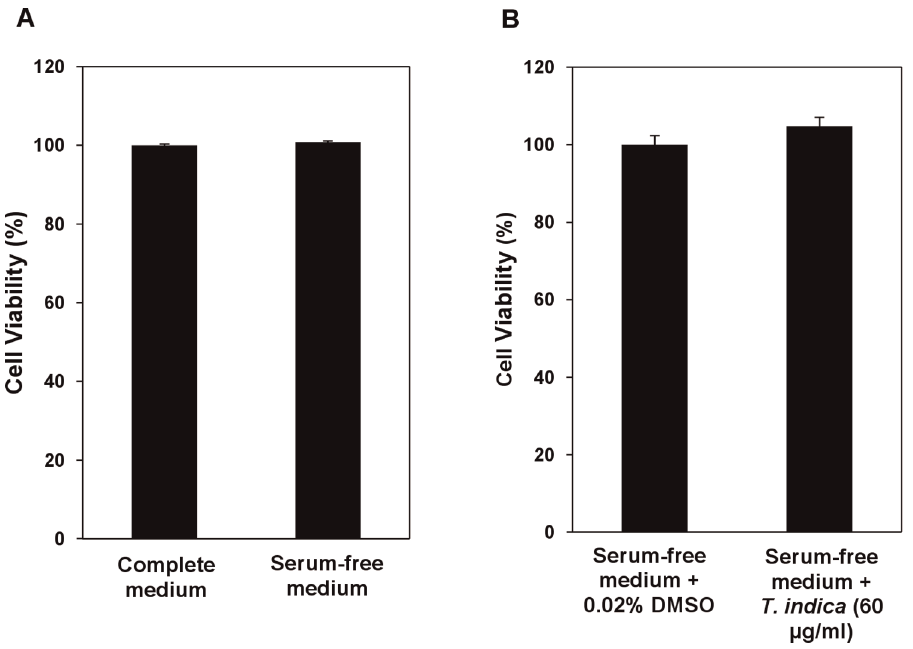
Figure 1. MTT analysis to assess cell viability. HepG2 cells were grown in complete or serum-free media (A) and in serum-free media in the presence of vehicle, 0.02% DMSO (control) or 60 m g/ml methanol extract of the T. indica fruit pulp (B). Assays were done in triplicate and all data are expressed as mean 6 S.E.M.